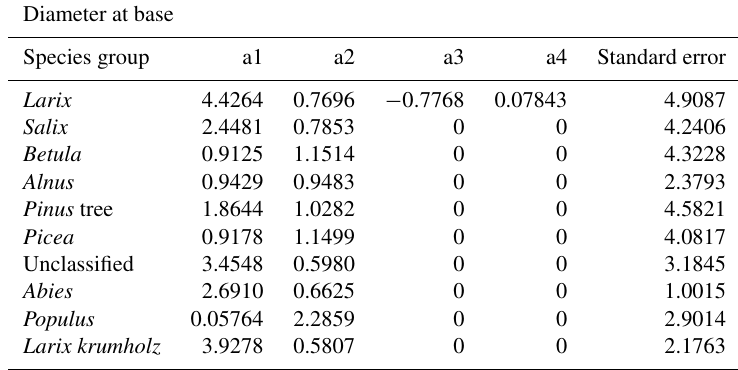
Table C1. Coefficients for diameter at base allometries.